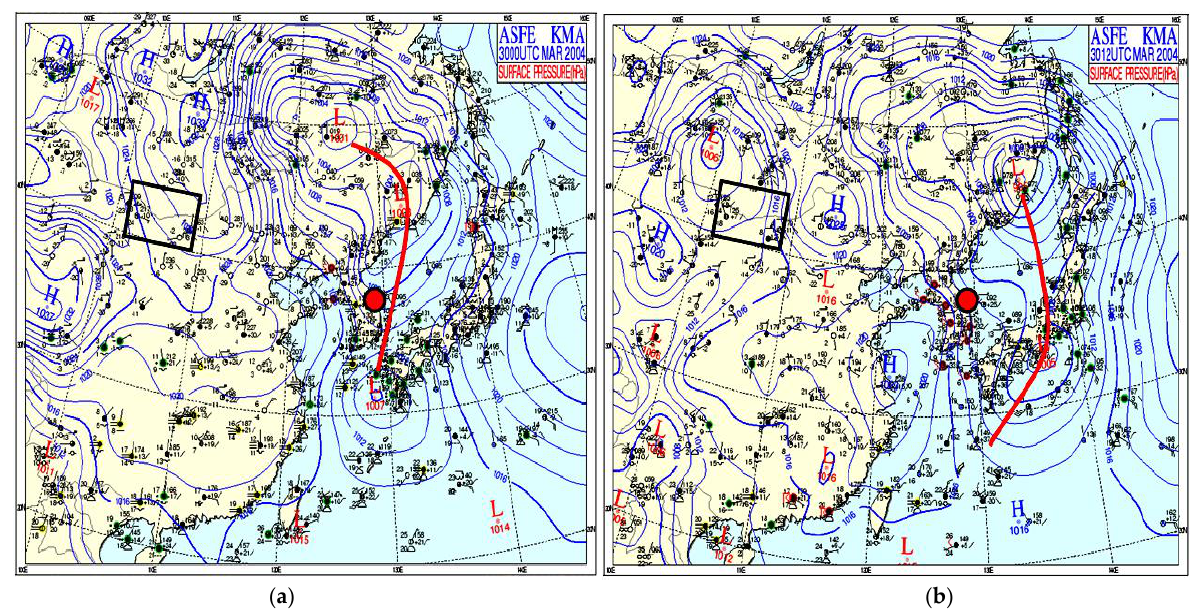
Figure 11. ( a ) Surface pressure at 09:00 UTC (00:00 LST), 30 March 2004, and ( b ) 12:00 UTC (21:00 LST). A small box, a thick red line, and a circle in ( a ) denote the Gobi Desert, cold front, and Gangneung city, respectively. In Figure 12a, dust particles on the green color line originated from 6000 m height of southwestern Russia on March 27 passed by about 6000 m height of the Gobi Desert and Nei-Mongo on March 28, and the Bohai Sea and Yellow Sea on March 29 and finally reached at 3000 m height of Gangneung city at 09:00 LST (00:00 UTC), March 30. Thus, these particles did not include the dust in the lower atmosphere of the Gobi Desert and Nei-Mongo and can not affect the increase of the ground-based PM